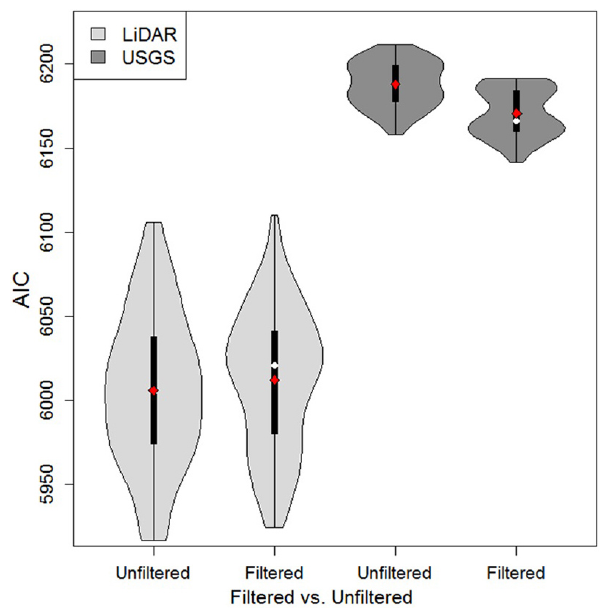
Figure 10. AIC values vs. smoothing for the lidar (light grey) and USGS (dark grey)